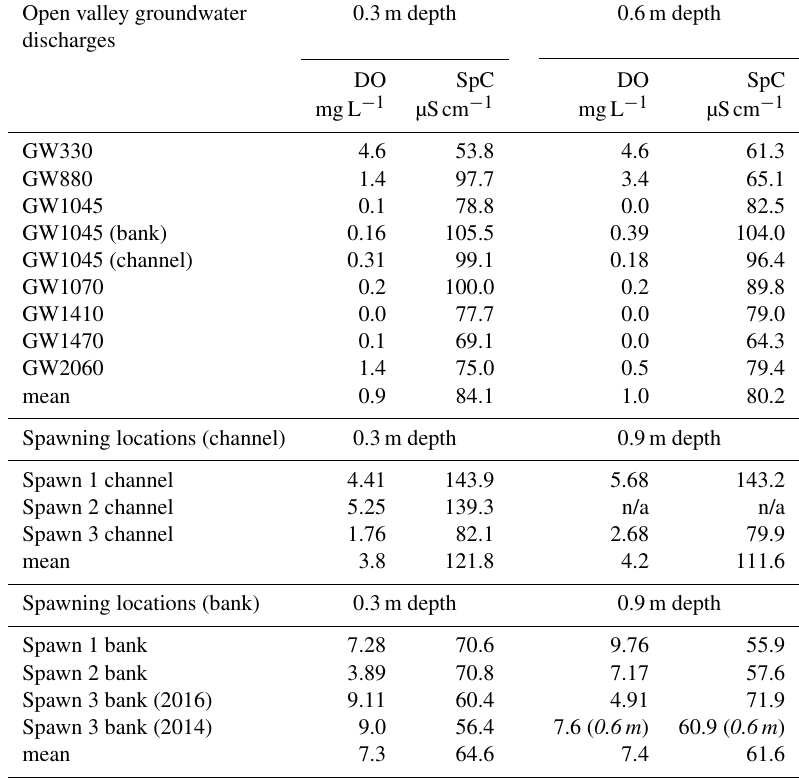
Table 1. This table lists 2014 and 2016 drive point pore-water chemistry data collected in major stream-bed groundwater-discharge zones located with fiber-optic heat tracing and in zones of observed repeat trout spawning directly along the bank and farther toward the stream center channel. The italicized values indicate sample depths that differ from others in the same